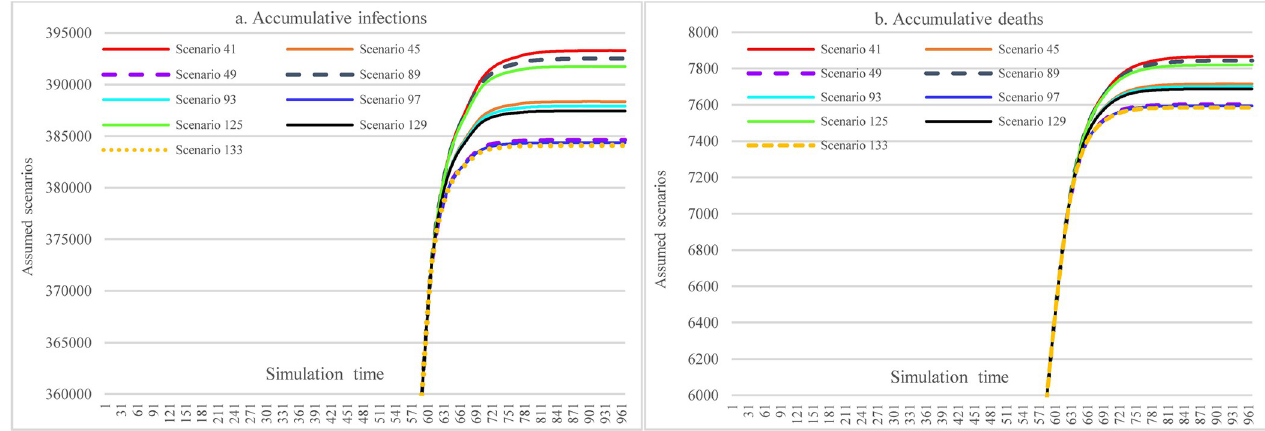
Fig 19. Impacts of changing vaccination levels and implementing social distancing measures with mask-wearing adherence level of 70%.